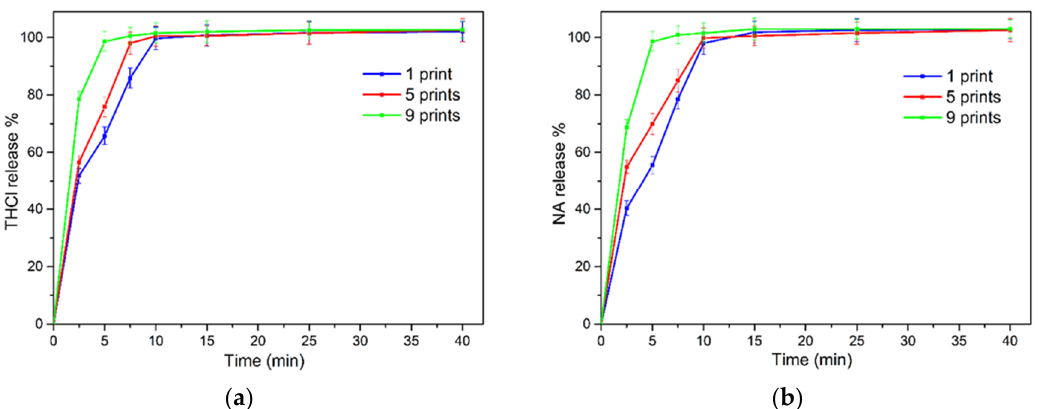
Table 3. Kinetic models fitting parameters.